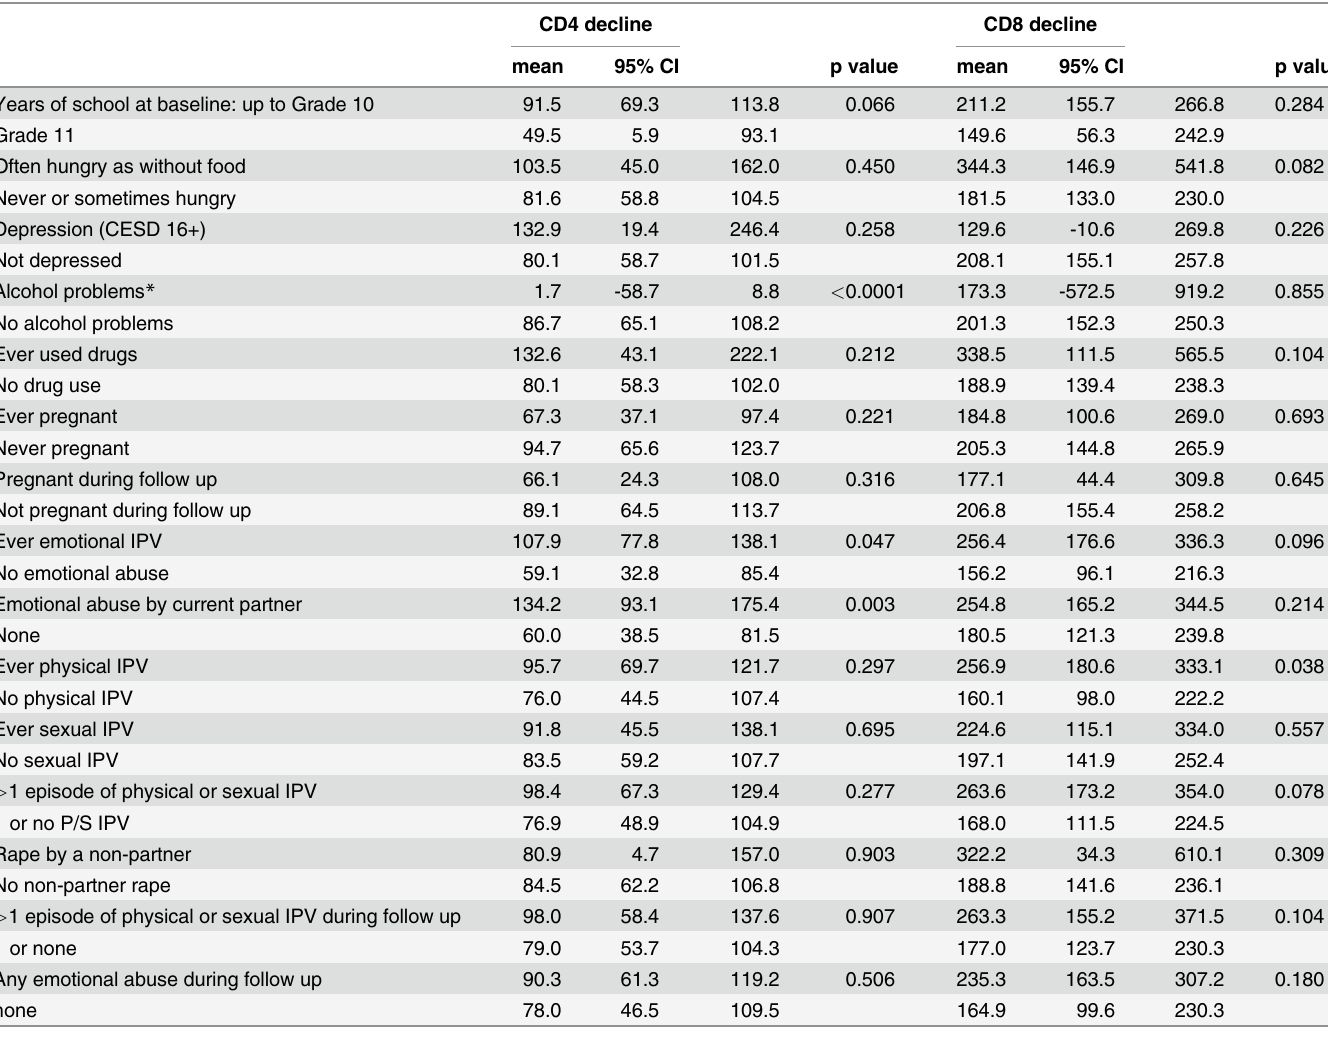
Table 2. Mean decline in CD4 and CD8 by exposure variables (at timepoint prior to observed decline, unless otherwise stated).